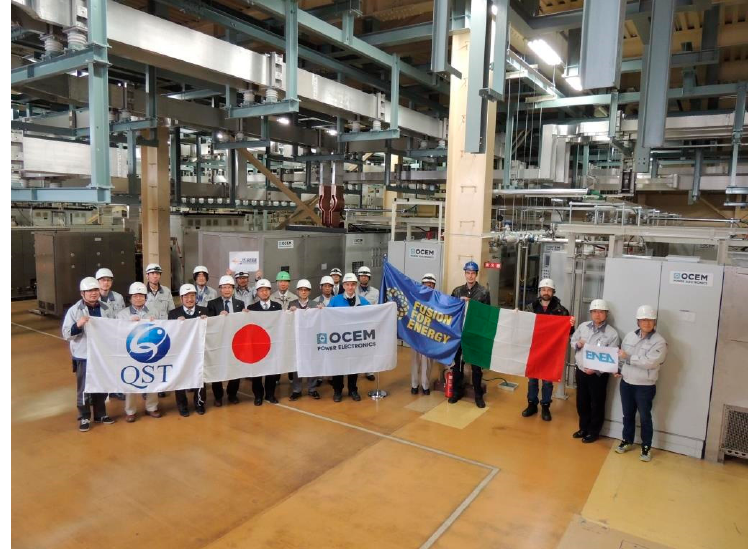
Figure 12. Group photo with the flags of the project partners in front of the SNUs to celebrate the successful completion of all the acceptance tests.